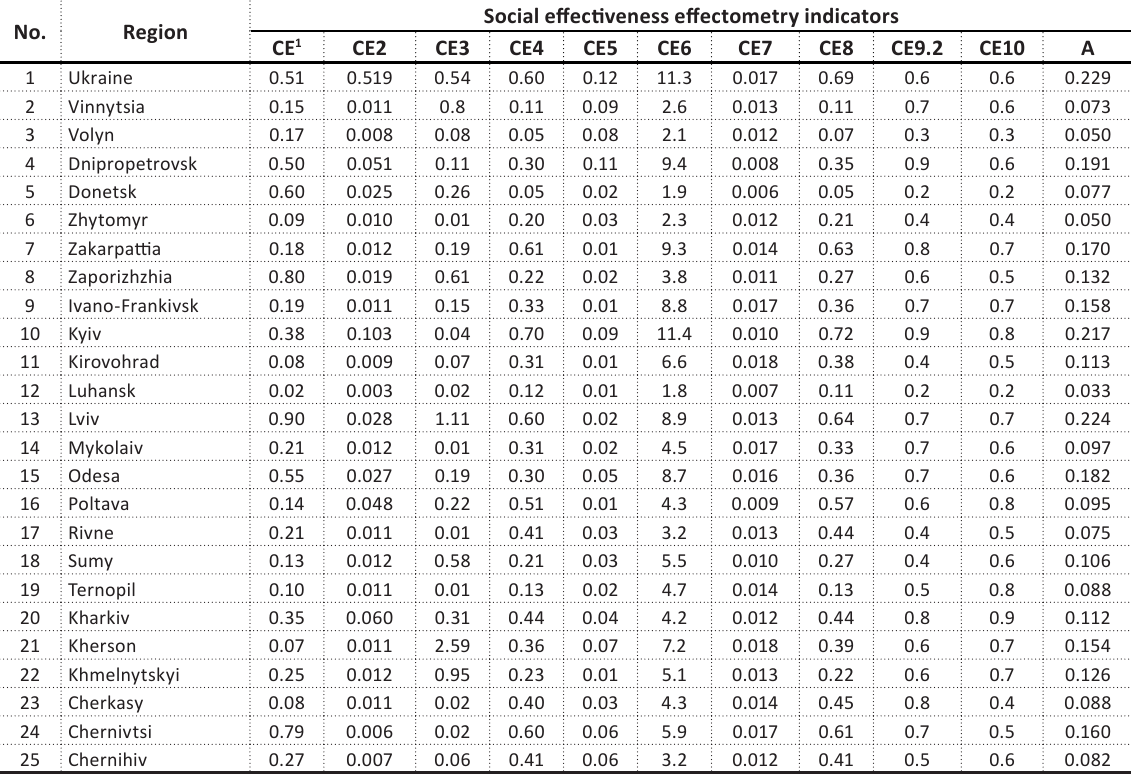
Table 3. Calculation of Ukrainian regions hospitality investment attractiveness indicators No.